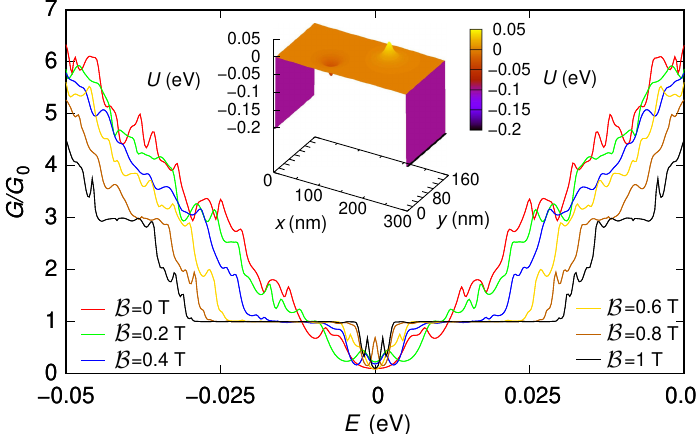
Figure 4. Conductance G , normalized with respect to the conductance quantum G 0 , which was obtained as a function of the Fermi energy E for six values of the orthogonal magnetic field B for the 150 nm-wide and 300 nm-long graphene ribbon with a potential given by the sum of two Lorentzian functions and two 5 nm-long sections at the entrance and exit, which represent abrupt contacts (with a modulus of 0.2 eV for the potential steps of the contacts). In the inset, we represent the potential profile that we have considered.